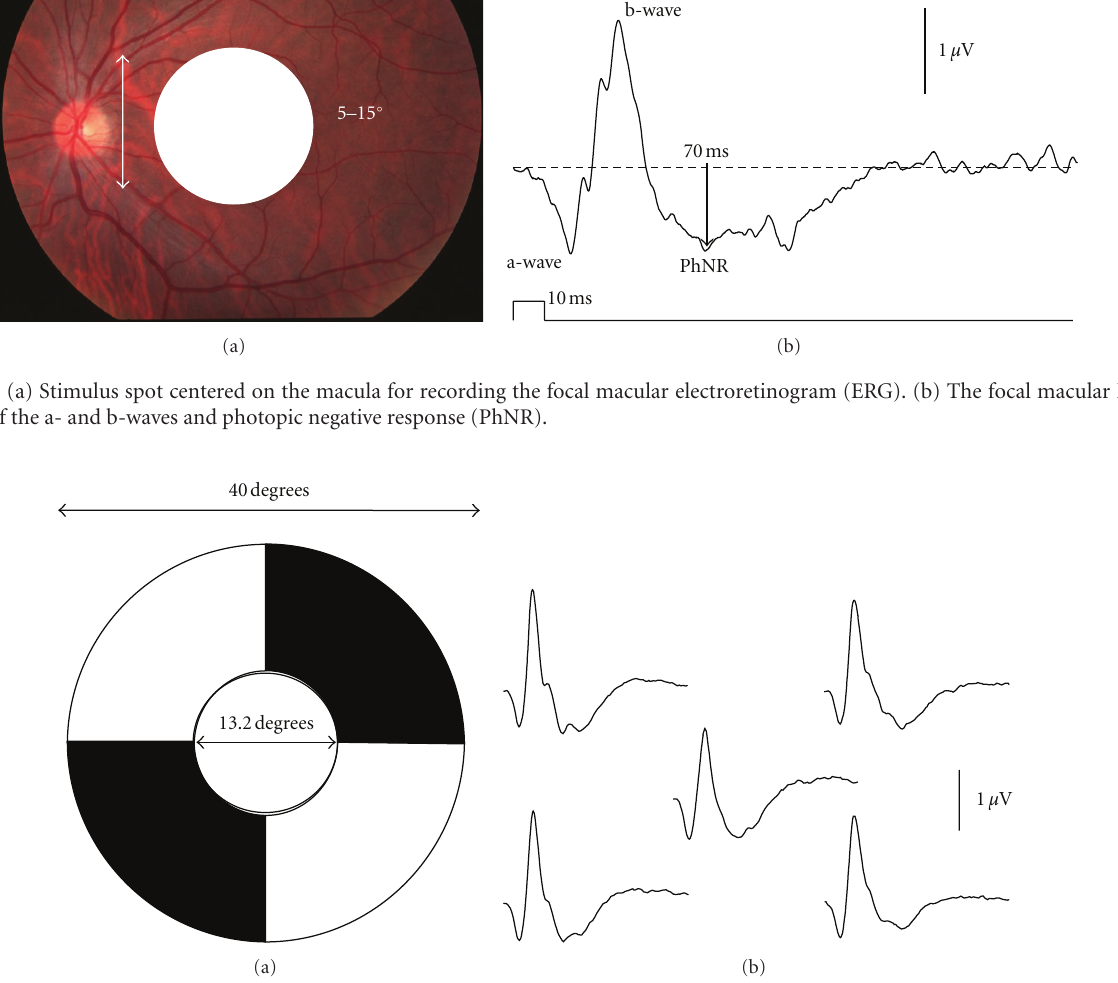
Figure 3: (a) A dartboard pattern of stimuli for recording the multifocal electroretinogram (ERG). (b) Normal waveforms of multifocal ERG recorded from each